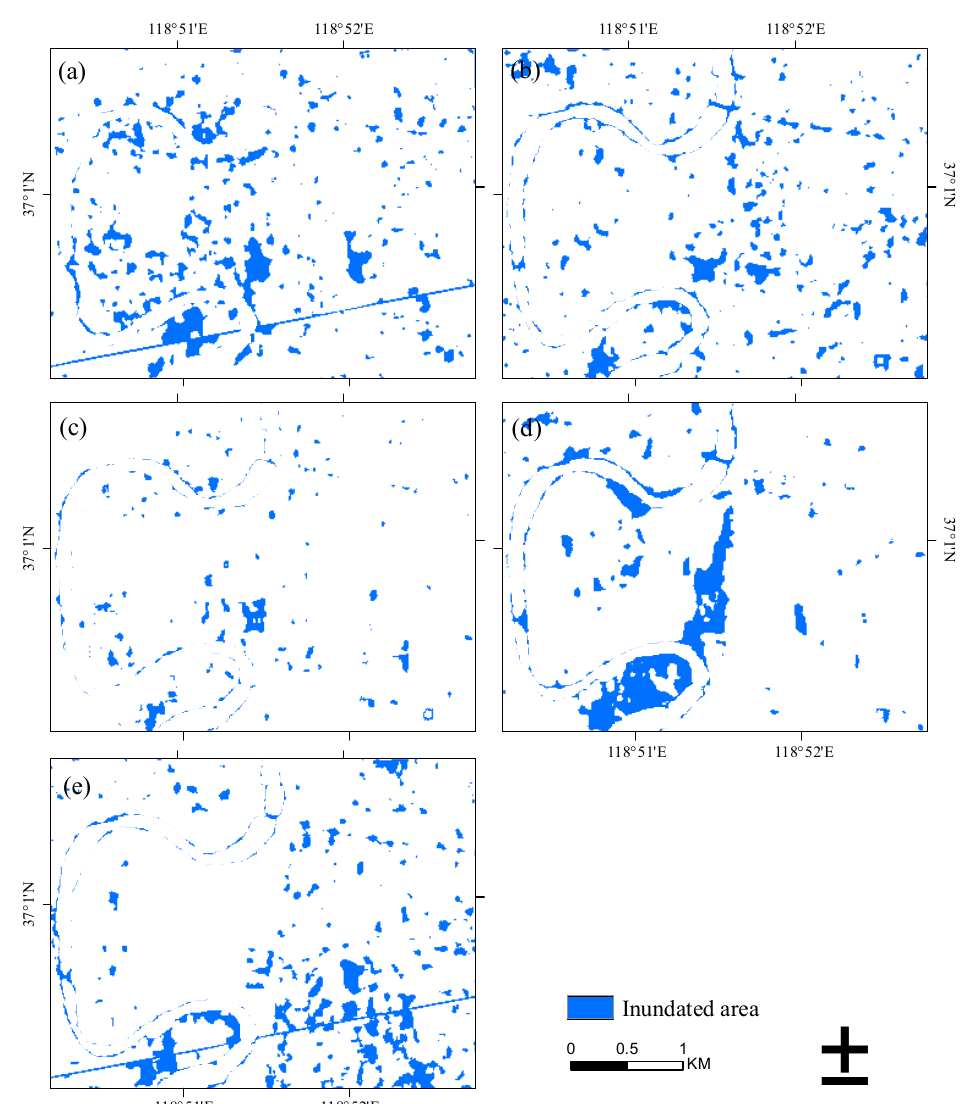
Figure 8. The inundated areas extracted from the binary maps based on a partial image on 21 July 2018 ( a ), 27 July 2018 ( b ), 2 August 2018 ( c ), 20 August 2018 ( d ), and 26 August 2018 ( e ).